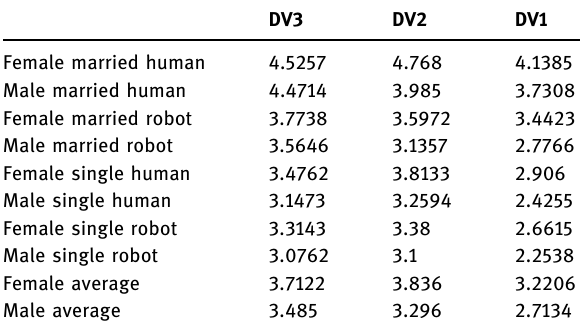
Table 3: Consistent gender di ff erence in rating DVs in di ff erent conditions